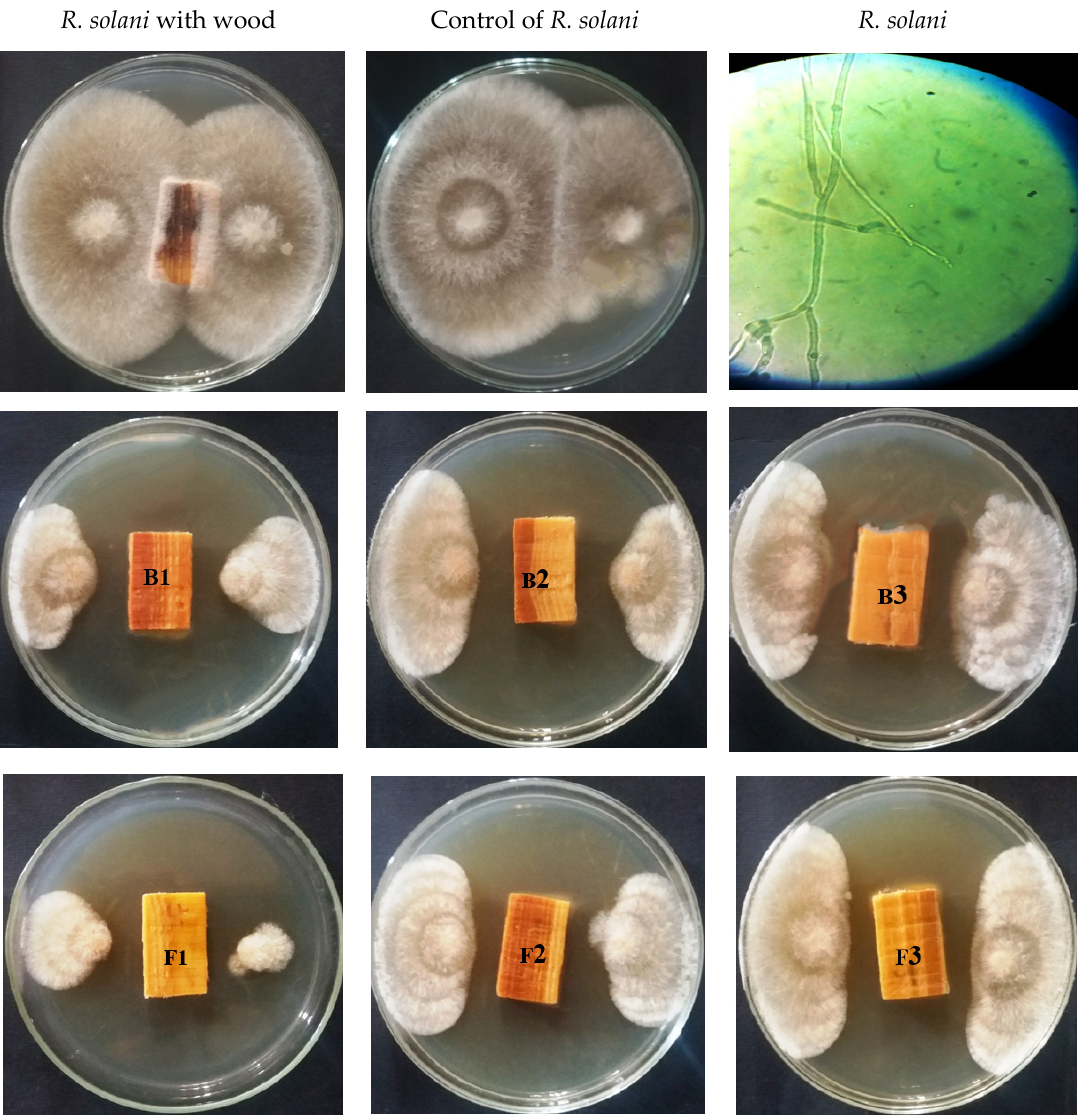
Figure 4. Antifungal bioassay of wood treated with (B) P. halepensis OLE and (F) S. terebinthifolius EO against the growth of R. solani . B1: 3%; B2: 2%; B3: 1%; F1: 3%; F2: 2%; F3: 1%.